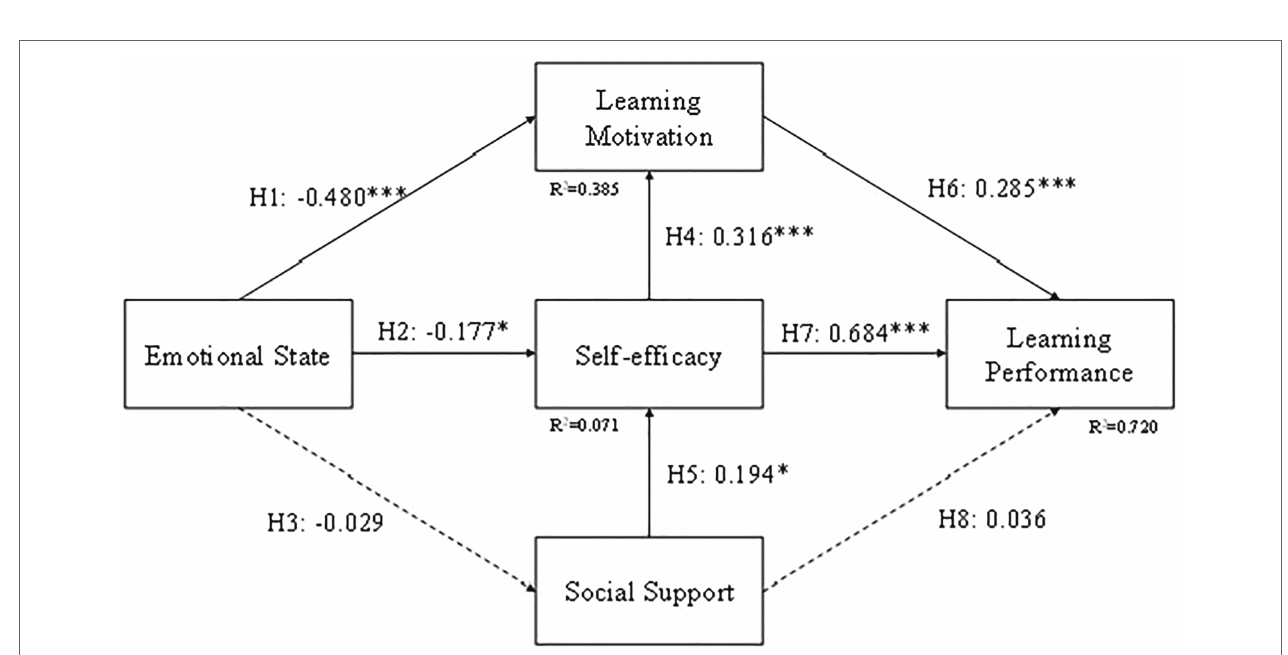
FIGURE 8 | Model result for CG. * p < 0.05; *** p <